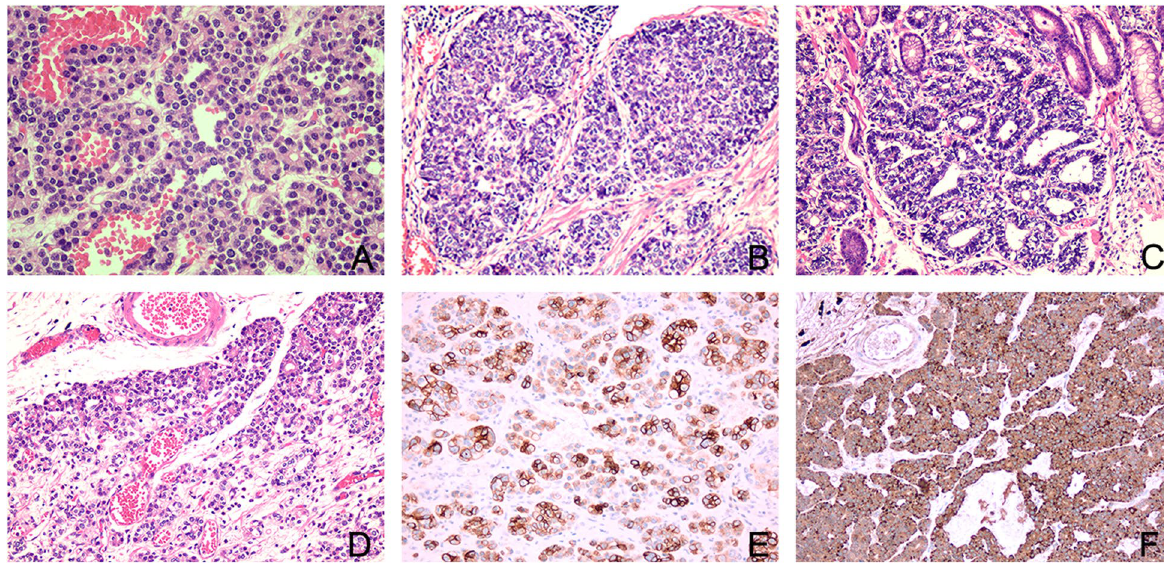
Fig. 2 The tumor arranged in acinar pattern ( A pattern ( C 200). Ectopic pancreatic tissue ( D × alpha-1-antitrypsin (